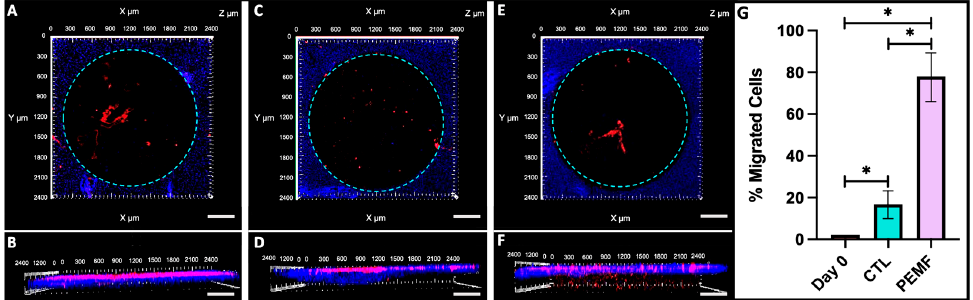
Figure 10. Representative confocal images of DiI ‐ stained FLS migrating into DAPI ‐ labeled cartilage defect. ( A ) Top and ( B ) side view of day 0 samples showing no FLS migration. ( C ) Top and ( D ) side view of control group (CTL) without PEMF stimulation for 48 h showing minimal cell migration ( E ) Top and ( F ) side view of explant exposed to PEMF for 48 h showing significant migration through the cartilage depth (Scale bar = 200 μ m). ( G ) Quantified cell count of FLS migration into the cartilage defect across day 0, CTL, and PEMF treated explants (* p < 0.001).